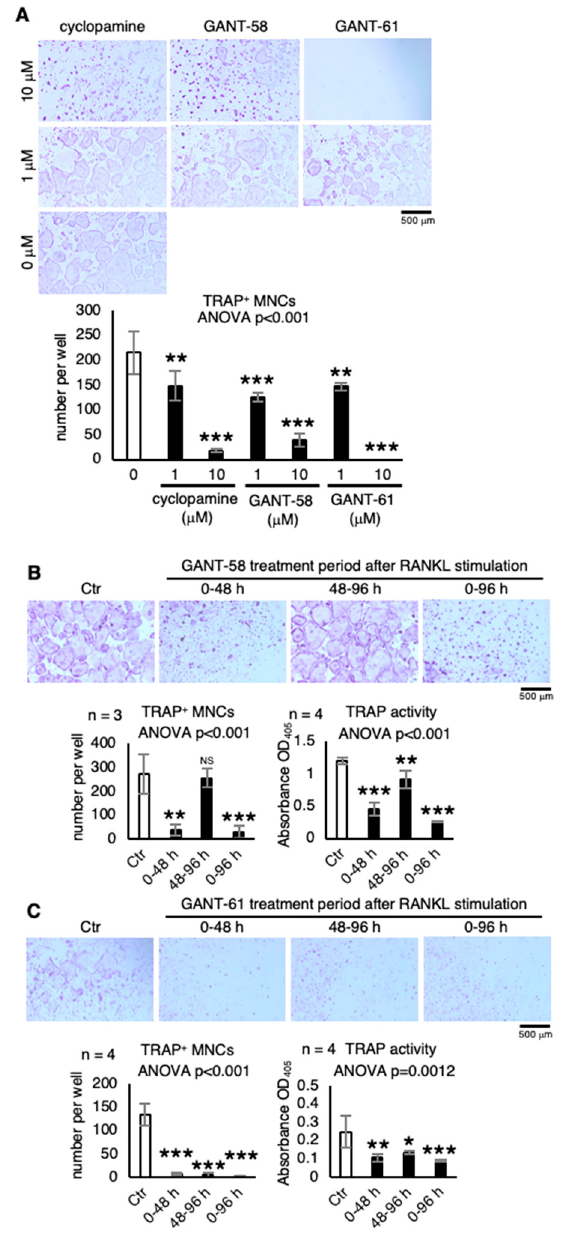
Figure 3. Other Hh signaling inhibitors that suppress osteoclastogenesis. ( A ) Effect of Hh signaling inhibitors cyclopamine, GANT-58, and GANT-61 on osteoclast formation. The number of TRAP + multinuclear cells (MNCs) were counted ( n = 3). ( B , C ) Osteoclastogenic cultures treated with ( B ) 10- μ M GANT-58 or ( C ) 5- μ M GANT-61 throughout the 96-h period (0–96 h) or only during the first (0– 48 h) or second period (48–96 h); the number of TRAP + multinuclear cells (MNCs) and TRAP activity determined at 96 h after RANKL stimulation ( n = 3–4). Data are represented as means ± s.d. One-way ANOVA, followed by Dunnett’s test; NS, not significant; * p < 0.05, ** p < 0.01, and *** p < 0.001.